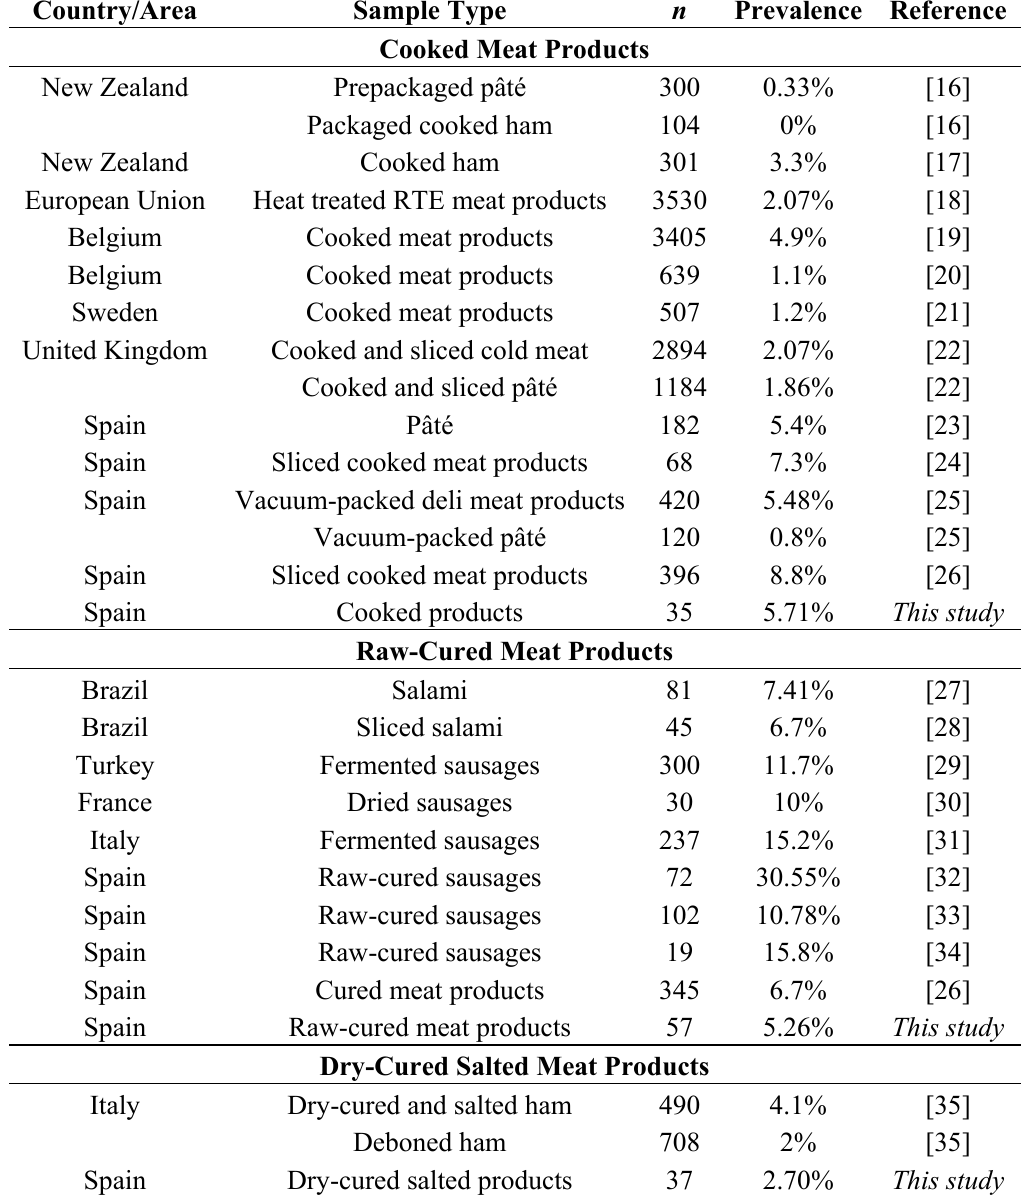
Table 2. Occurrence studies of L. monocytogenes in RTE meat